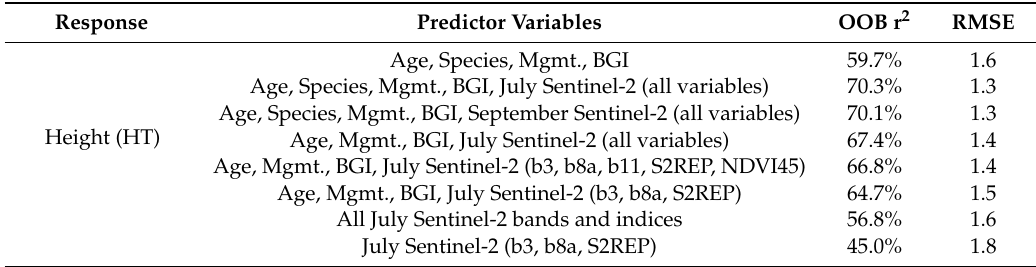
Table 4. Results of height (HT) (m) prediction by Random Forest using species composition, age, management type, BGI and Sentinel-2 spectral bands and